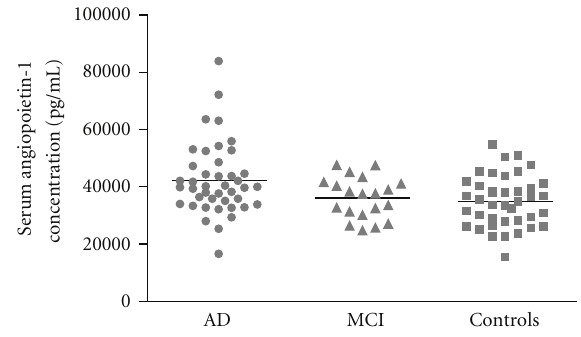
Figure 1: Angiopoietin-1 (Ang-1) serum levels (ng/mL) in Alzheimer’s disease (AD) patients, mild cognitive impairment (MCI) patients, and healthy elderly controls. AD patients showed significantly higher Ang-1 serum levels compared with healthy controls ( P = 0 . 003). There was no significant di ff erence between MCI patients and healthy controls ( P = 0 . 553) nor between AD and MCI patients ( P = 0 .